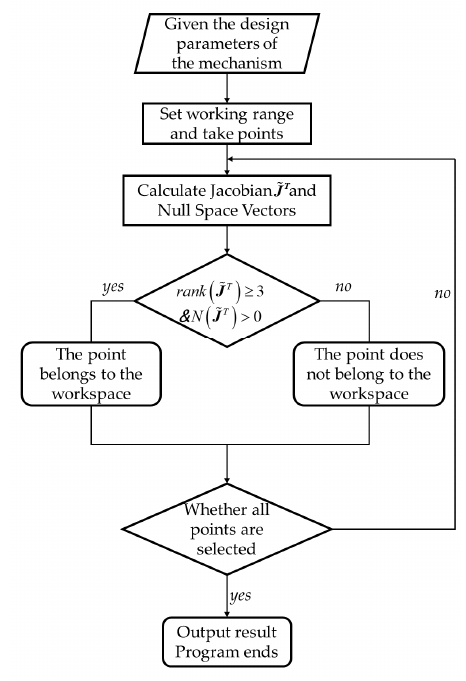
Figure 4. Flow chart of workspace discrimination.